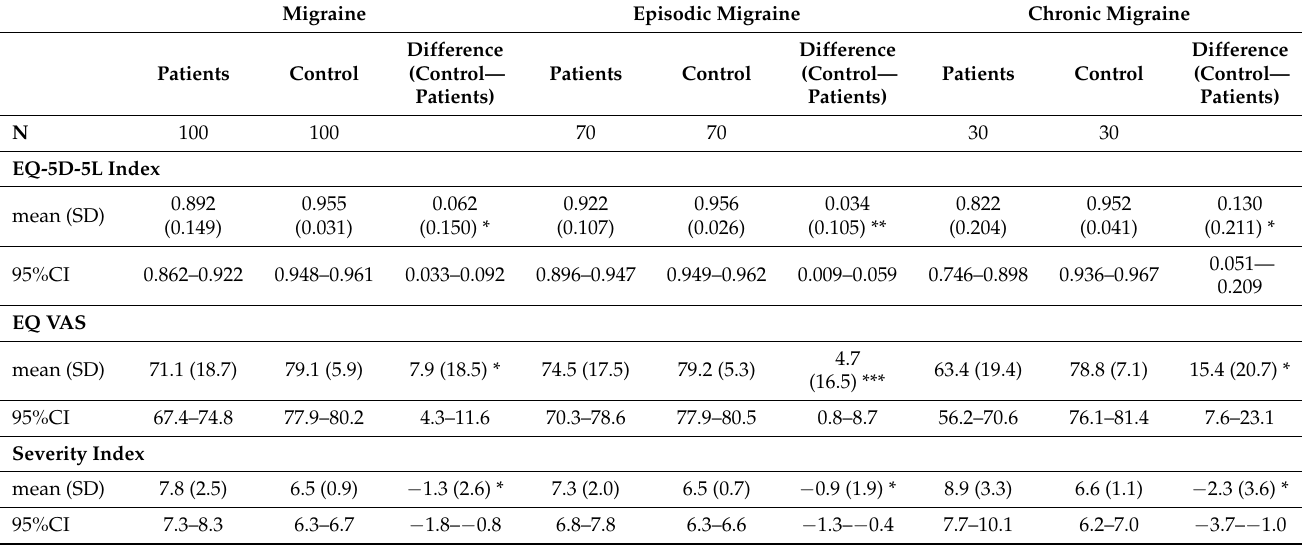
Table 2. EQ-5D-5L outcomes in patients with migraine and control group.